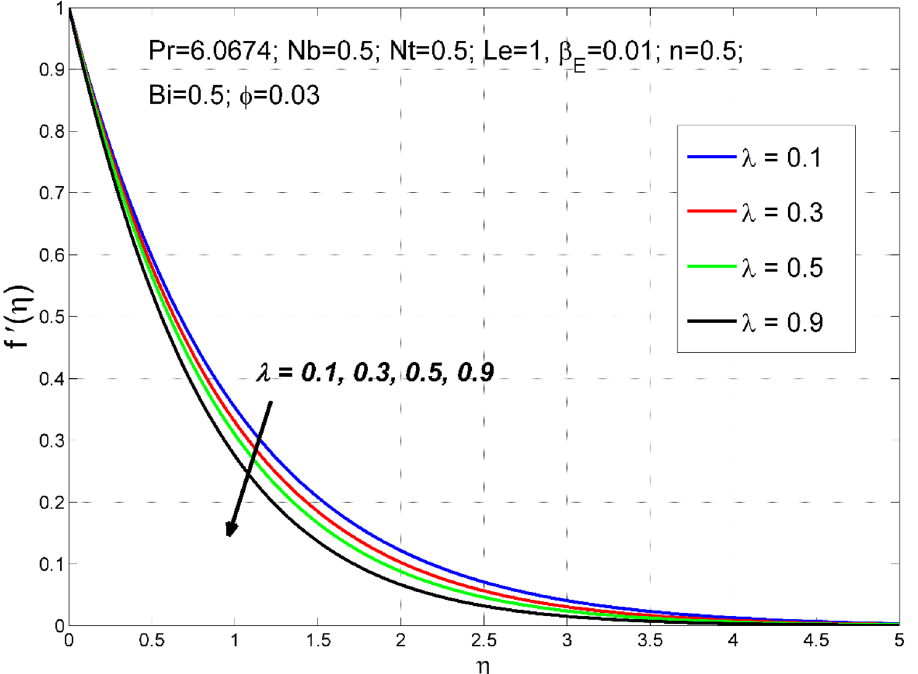
Figure 2. The axial velocity f ′ (η) behavior for the variation of the stretching ratio (cid:31)